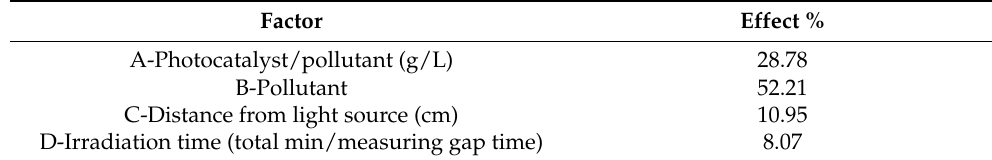
Table 3. Percentage of effect of each factor on the final degradation according to Taguchi method.